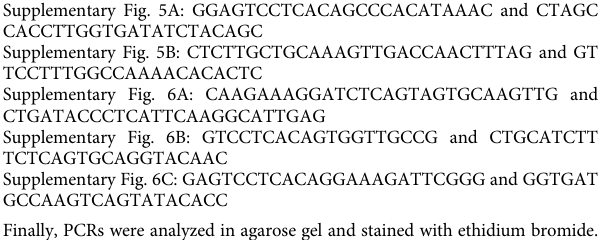
GPHN alternative transcripts were detected by analyzing 21 human tissues with targeted long reads sequencing. Human tissues are listed in the left column while corresponding GPHN splice variants are displayed in the right